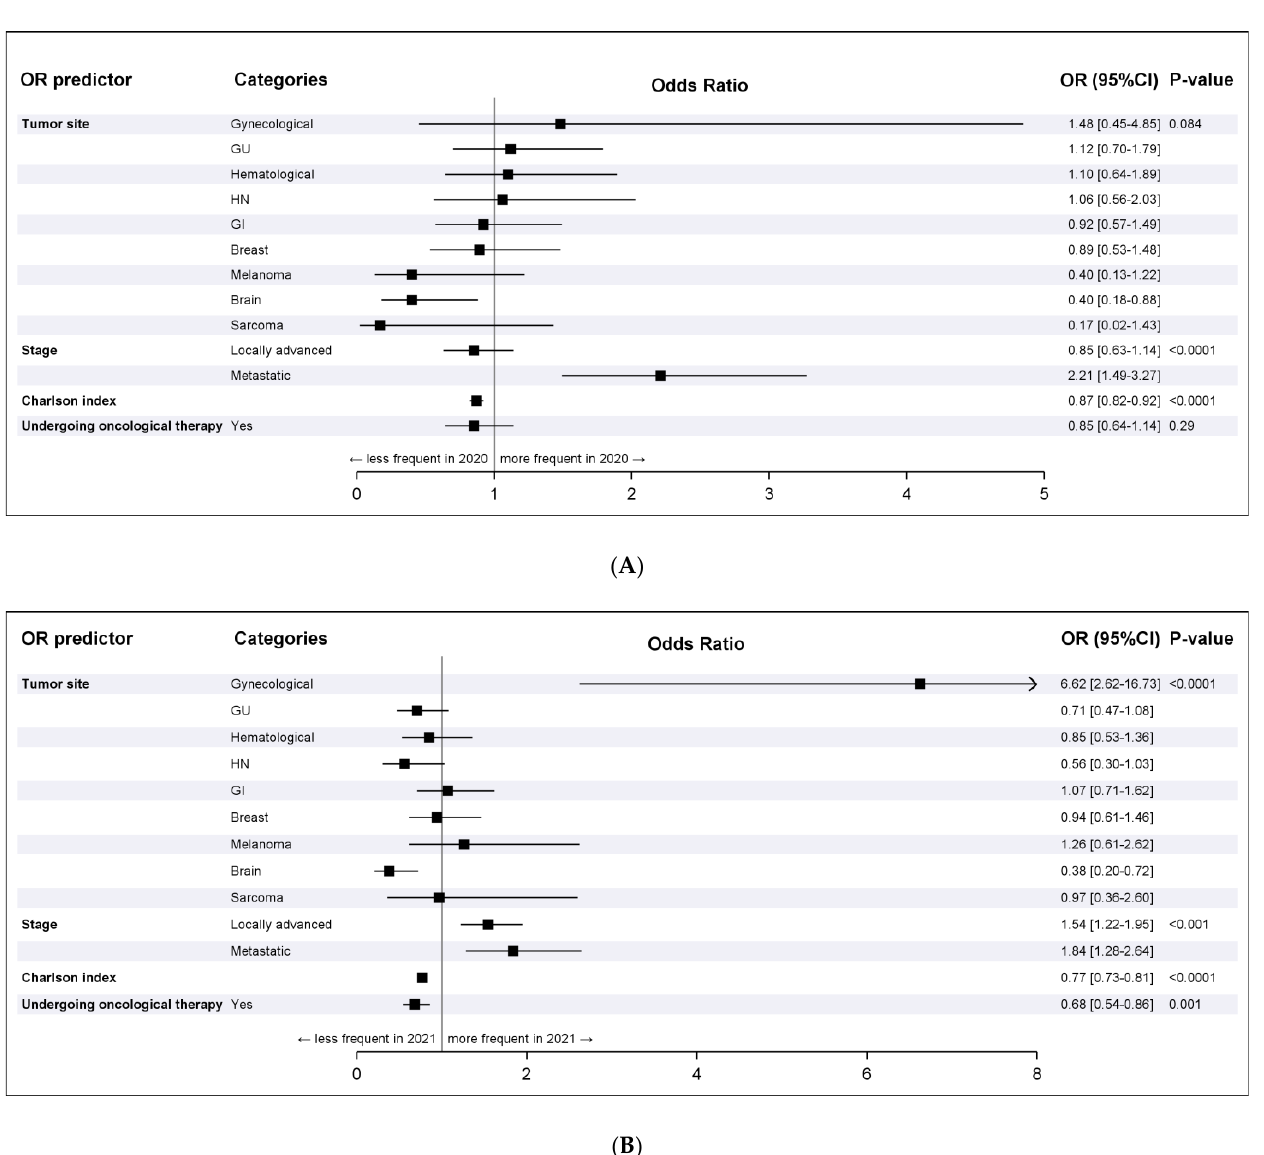
Figure 1. Multivariate analysis. ( A ) 2020 vs. 2019. ( B ) 2021 vs. 2019. Note: OR estimates were ob-